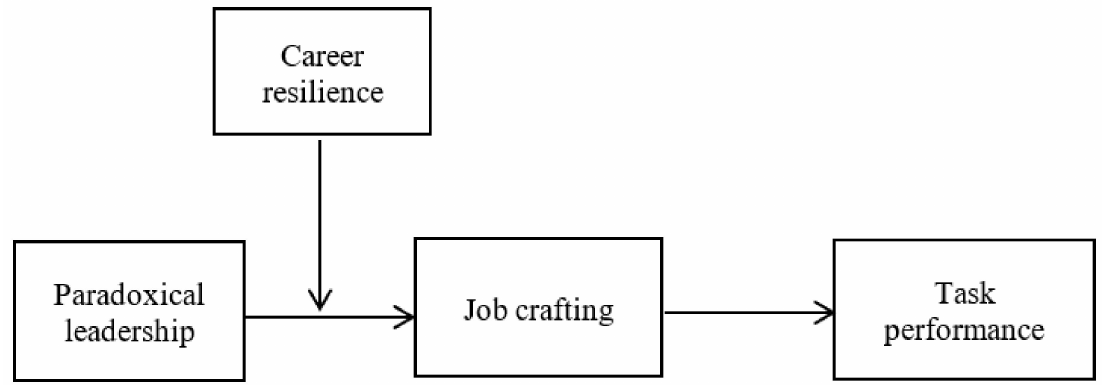
Figure 1. The conceptual